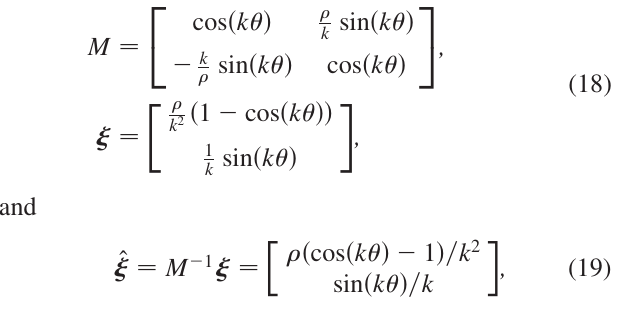
TABLE I. Optimal lattice parameters at the entrance and the center of a dipole under achromatic and TME conditions. Achromatic TME (cid:8)